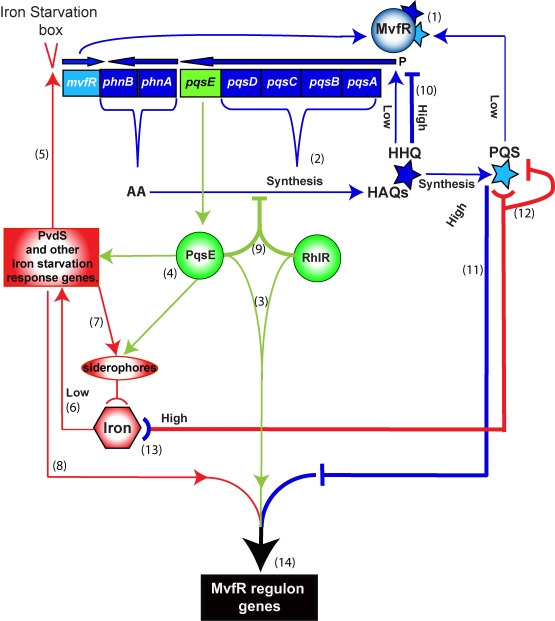
Schematic of the positive and negative homeostatic interplay among the MvfR regulon components PqsE, and PQS and HHQ with RhlR and iron.PqsE (green), HHQ and PQS (blue) and iron (red) play a dual role in up- or down-regulating the MvfR regulon. The outcome—that is the level of downstream gene expression translated into the bacterial virulence response—is the integrated sum of these interactions. Positive loops (thin lines): (1) MvfR is induced by HHQ and its derivative PQS to express phn and pqs operons, which are in turn (2) responsible for the synthesis of HAQs. PqsE is not required for HAQ synthesis and does not need AA or its derivatives for its “bottleneck” function, (3) controlling the expression of many virulence factors in cooperation with the AHL regulator RhlR. (4) PqsE also controls many iron starvation response genes, such as PvdS and siderophores. (5) PvdS in turn up-regulates the transcription of mvfR via an iron starvation box. (6) Low iron conditions also contribute to the induction of PvdS and other iron-related regulators to activate the iron response including (7) uptake of iron into the cell by siderophores as well as (8) induction of the virulence response. Negative loops (thick lines): (9) PqsE in cooperation with RhlR down-regulates the expression of the phn and pqs operons, thus reducing HAQ production. When a threshold concentration of HHQ is reached, (10) HHQ down-regulates the pqs operon. (11) PQS at high physiological levels in turn counterbalances the expression of PqsE-controlled genes, including many virulence factors. High levels of iron in presence of low levels of PQS, reduce P. aeruginosa virulence, at least in part, by (12) binding and inactivating PQS. In contrast, when PQS is at high physiological levels its inactivation by iron will increase virulence by reducing the negative PQS counterbalance and thus sustain the positive loops that include (13) iron starvation as a result of PQS trapping iron. (14) The integration of these processes enforces a fine-tuning of MvfR regulon gene expression levels, therefore determining the magnitude of virulence.